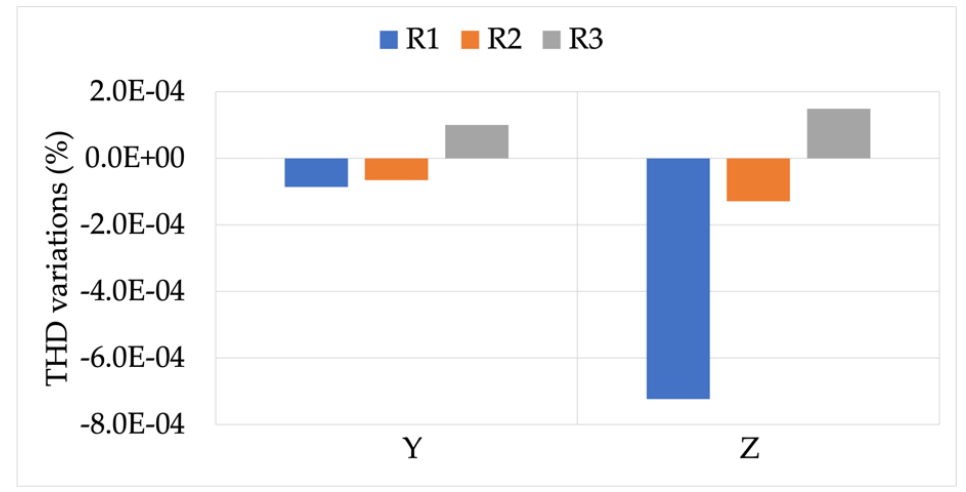
Figure 10. THD variations, compared to position L, obtained from measurements at the position N.